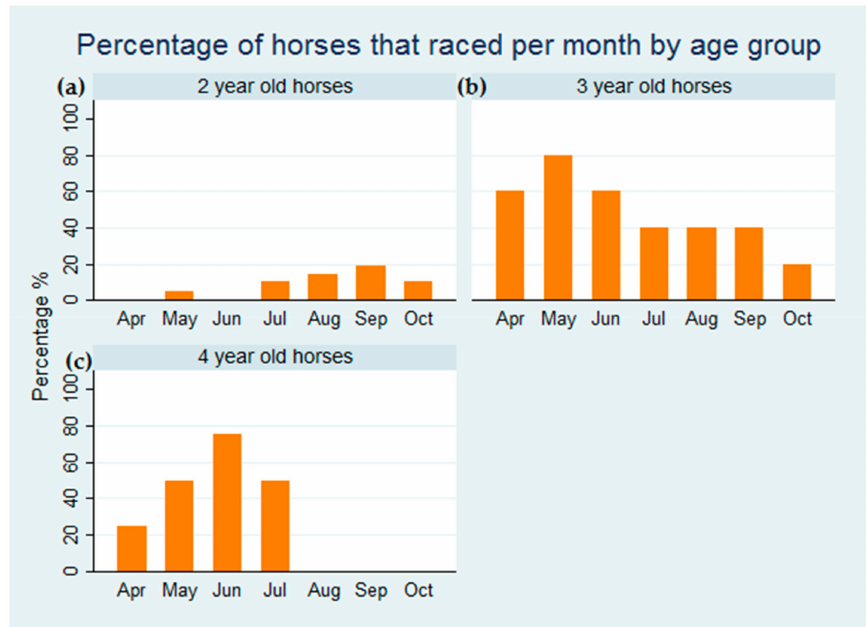
Figure 2. The percentage of horses that raced per month during the study period. The percentage of ( a ) two-year-old horses ( b ) three-year-old horses and ( c) four-year-old horses that raced is shown. The time from seroconversion to ERAV until the titers decreased to insignificant levels ranged from three weeks to five months, with a median value of two months and a mean value of 2.3 months. An association was observed between the antibody level and the rate of decline to original